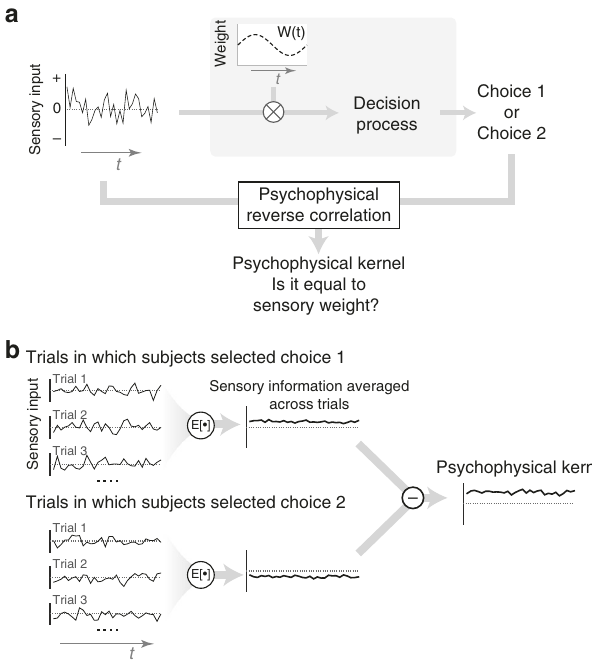
Fig. 1 Psychophysical reverse correlation has been developed to recover sensory weights in perceptual tasks but it could also be in fl uenced by decision-making mechanisms. a In a typical reverse correlation experiment, subjects receive a sequence of randomly fl uctuating sensory information and make a binary choice. Experimenters can directly observe the stimulus and choice, but not the sensory weights and decision-making process (gray box). When choices are made by applying a sensory fi lter (weighting function) to the stimulus and comparing the result against a criterion, as proposed by signal detection theory, psychophysical reverse correlation will recover the sensory fi lter. However, it is unknown how well the analysis generalizes to more complex decision-making mechanisms. b Reverse correlation calculates the average stimuli preceding each choice and subtracts the results for the two choices. The outcome is a “ psychophysical kernel.